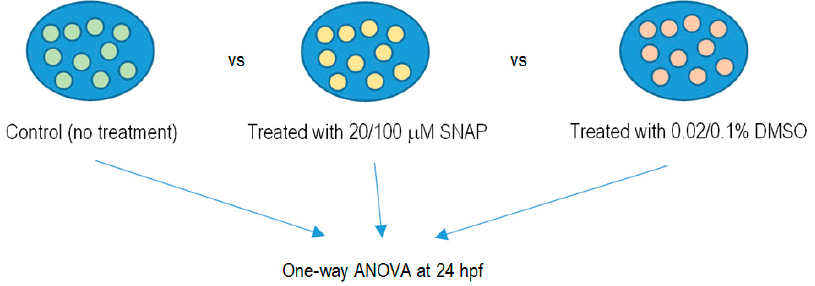
Figure 3. Comparison among different groups of embryos to test the cytotoxicity of SNAP.